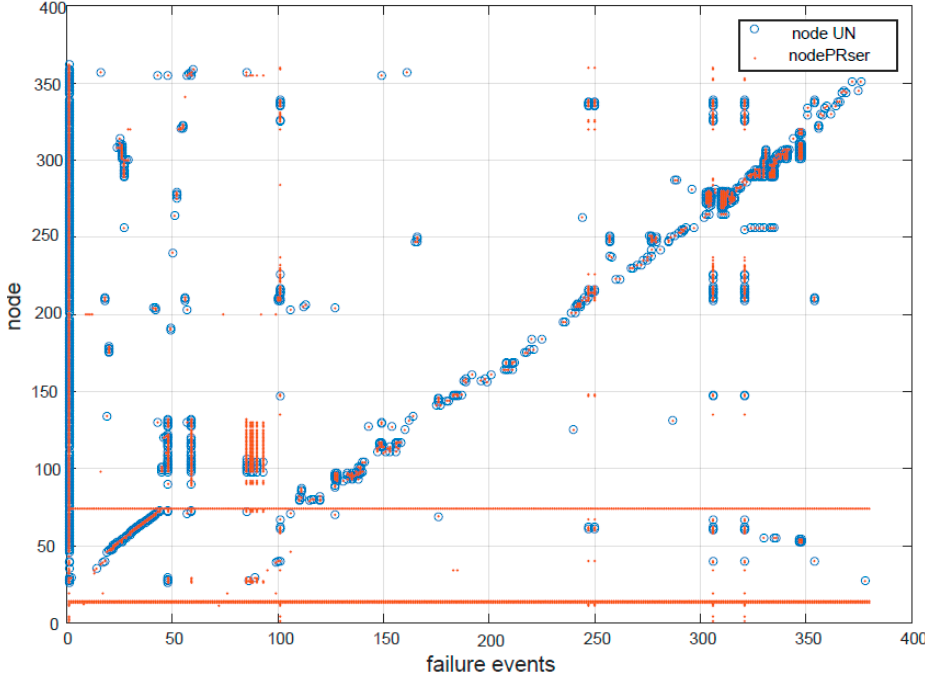
Figure 7. Scatter plot of node IDs that are affected by each failure event in case study of Laives